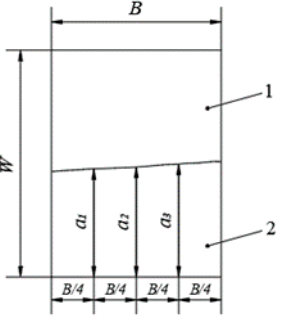
Figure 4. Ideal fracture surface.